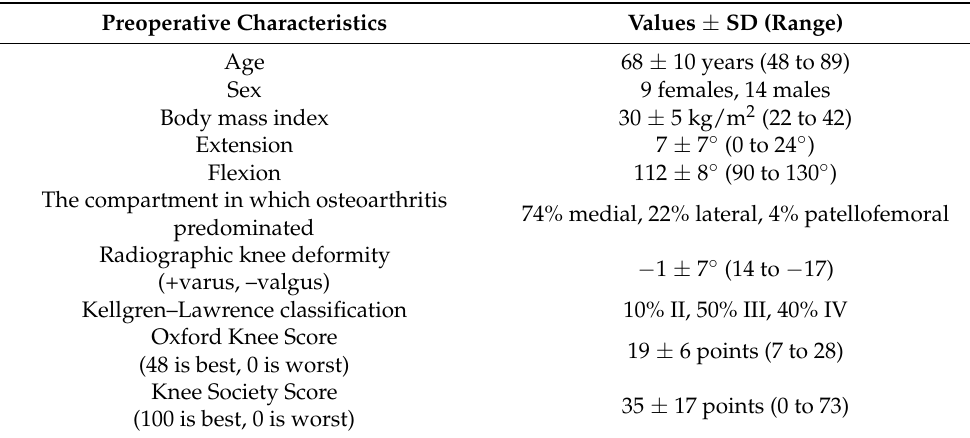
Table 1. Preoperative characteristics, knee conditions, and function scores for the 23 patients in the present